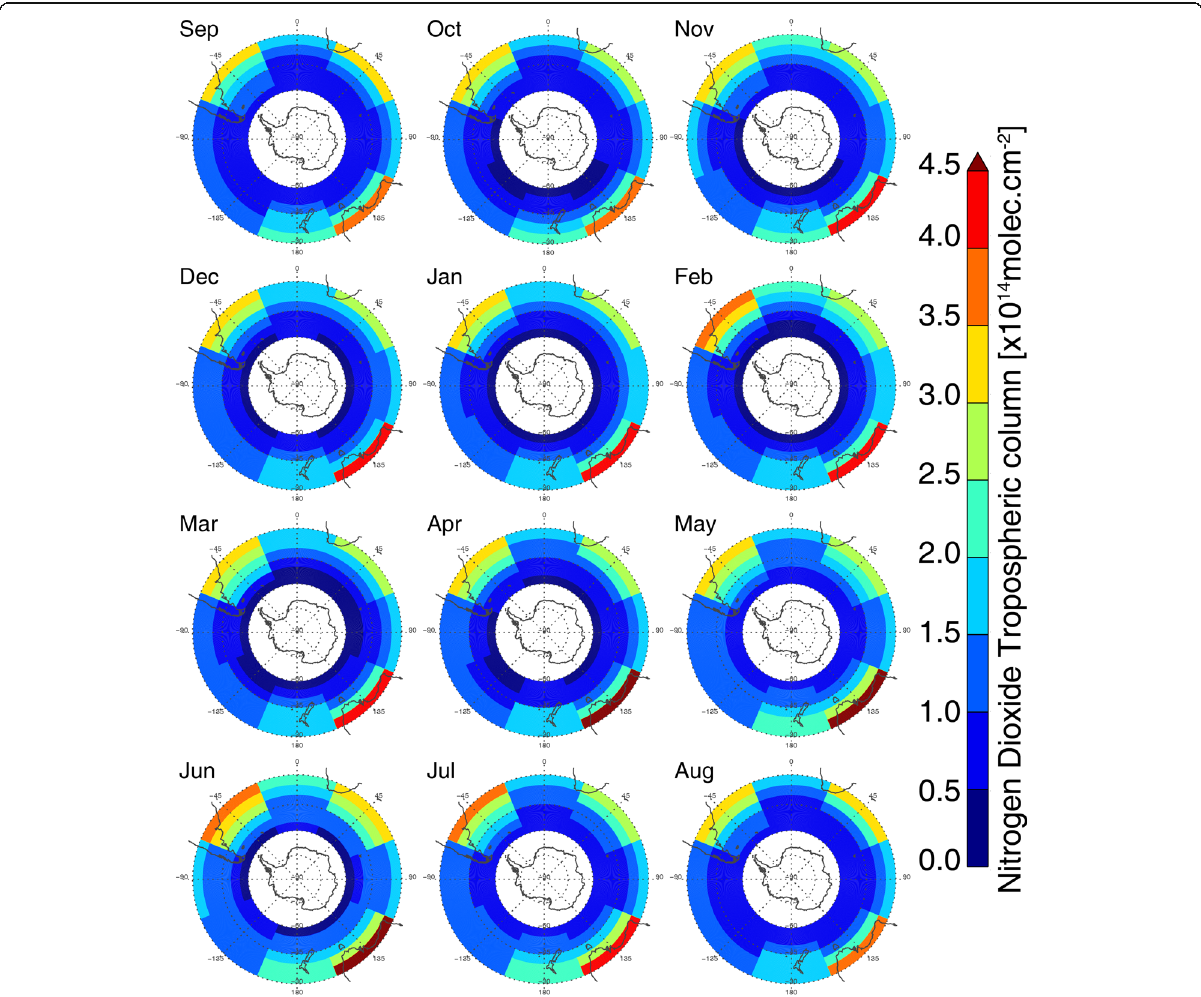
Fig. 3 Climatological monthly mean distribution of the OMI nitrogen dioxide (NO 2 ) tropospheric column (×10 14 molecule cm − 2 ) at 30 – 60° S. The color in each pixel reveals the median NO 2 value for all available measurements from 2005 to